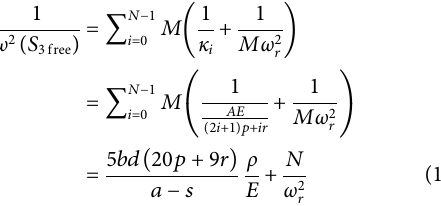
FIGURE 4 Ratio f MSblocked / f r (red dashed line) and f MSfree / f r (blue solid line) versus the number of internal oscillators N .